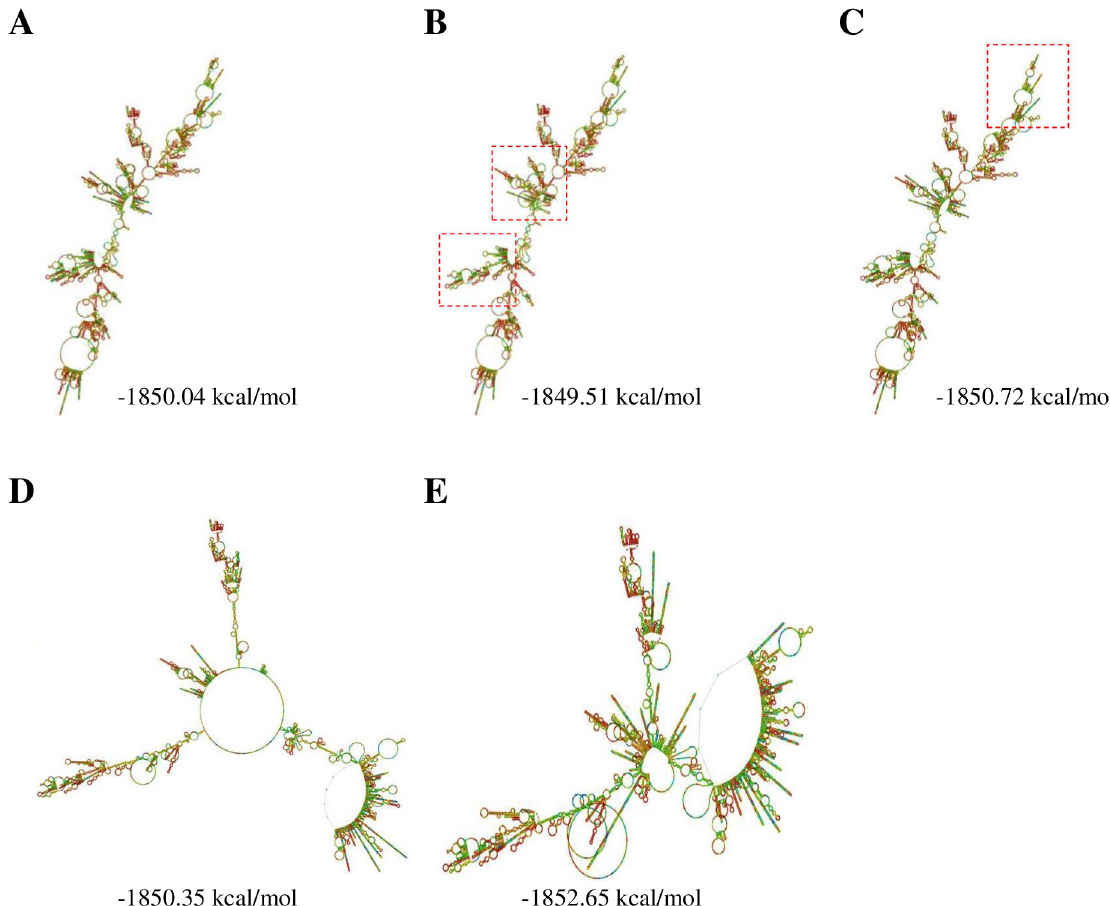
Fig 4. Changes in RNA structures of UCA1 variants with different haplotypes. The predicted RNA structures of ( A ) wild-type UCA1, ( B ) UCA1 variant with the GA haplotype of rs113579010-rs73003273, ( C ) UCA1 variant with the GG haplotype of rs113579010-rs73003273, ( D ) UCA1 variant with the GG haplotype of rs113579010-rs73005445, and ( E ) UCA1 variant with the AG haplotype of rs73003273-rs73005445. Full-length RNA strucures of those UCA1 variants were predicted by RNAfold web server